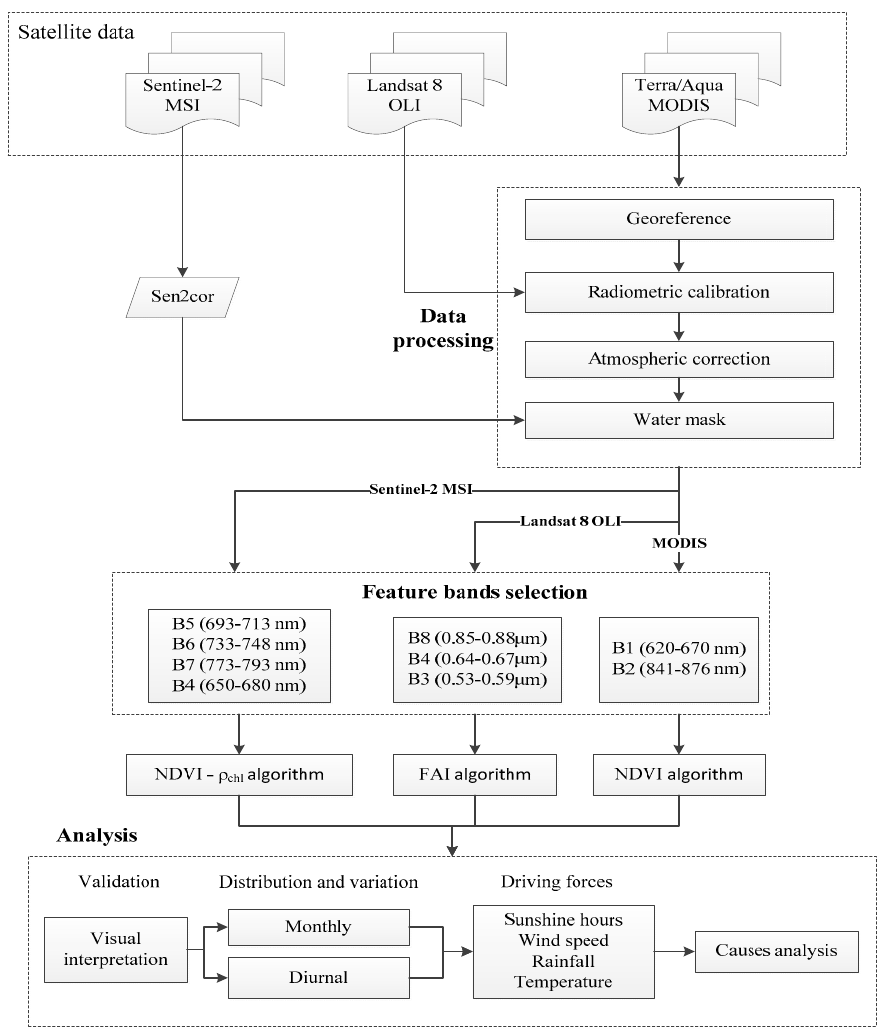
Figure 4. Technical route flow chart.